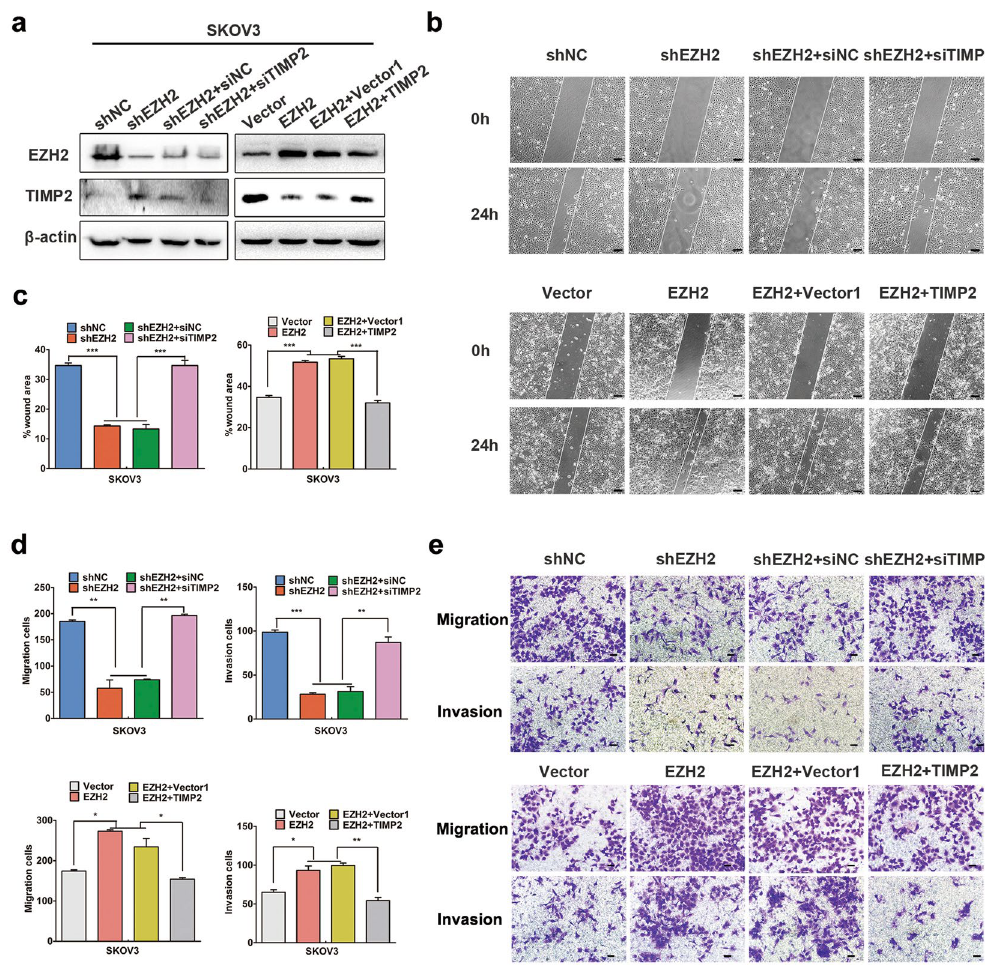
Figure 3. EZH2 promotes ovarian cancer cell invasion and migration by repressing TIMP2. Cells were transfected with shEZH2, shEZH2 and siTIMP2; EZH2-plasmid, EZH2-plasmid and TIMP2-plasmid and corresponding controls. ( a ) Western blot analysis of EZH2 and TIMP2 in SKOV3 cells after co-transfection. The cropped blots are used in the figure, and full-length blots are presented in Supplementary Fig. S8. ( b ) Scratch- wound assays for the detection of cell mobility (scale bar, 100 μ m). ( c ) Histograms show the wound-healing areas of the scratch-wound assays. ( d ) Transwell migration and invasion assays. The number of invading and migrating cells is presented. ( e ) Representative images of migration and invasion assays (scale bar, 50 μ m). * P < 0.05; ** P < 0.01; *** P <